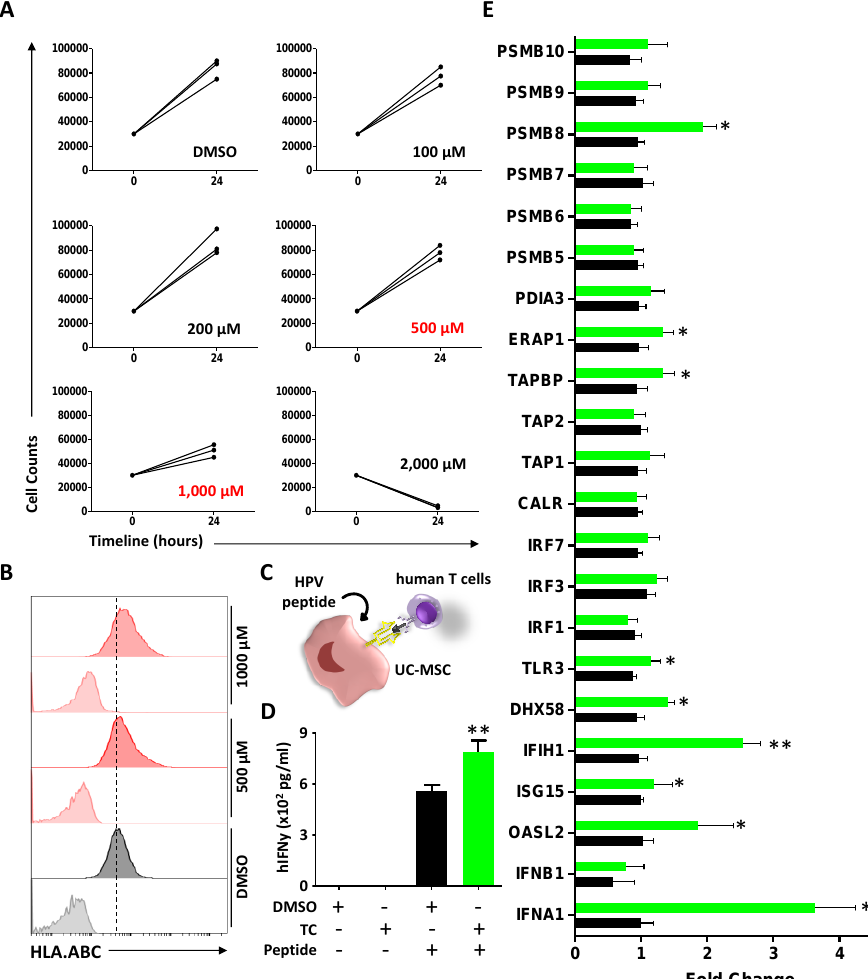
Figure 7. TC treatment leads to similar outcomes on human UC-MSCs. ( A ) Identification of the MTD for TC on human UC-MSCs. ( B ) Representative flow-cytometry analysis of HLA-ABC expression following DMSO (gray) or TC (red) treatments. ( C ) Schematic diagram of the antigen presentation assay using UC-MSCs. ( D ) Antigen presentation assay using TC-treated human UC-MSCs stimulated with the YMLDLQPET HPV peptide. ( E ) Quantification of gene transcripts in response to TC treatment. For this panel, n = 5/group with * p < 0.05, ** p < 0.01, and *** p < 0.001.